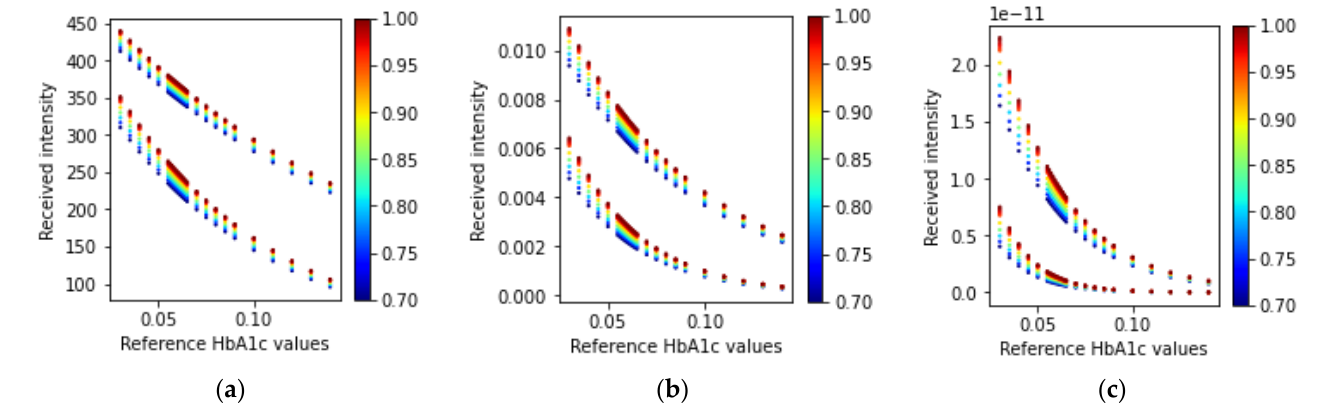
Figure 16. Received intensity values at the three different PDs shown in Figure 9 ( a ) sensor 1, ( b ) sensor 2, and ( c ) sensor 3 for the 615 nm wavelength of light. In each scatter plot, the top adjacent points correspond to the diastolic phase and the bottom points correspond to the systolic phase. The color bars at the side of the plots indicate the different SpO 2 values ranging from 70% to 100%. The ratio values calculated using Equations (23) and (24) for the multiple PDs with a single-wavelength LED arrangement are illustrated in Figure 17.